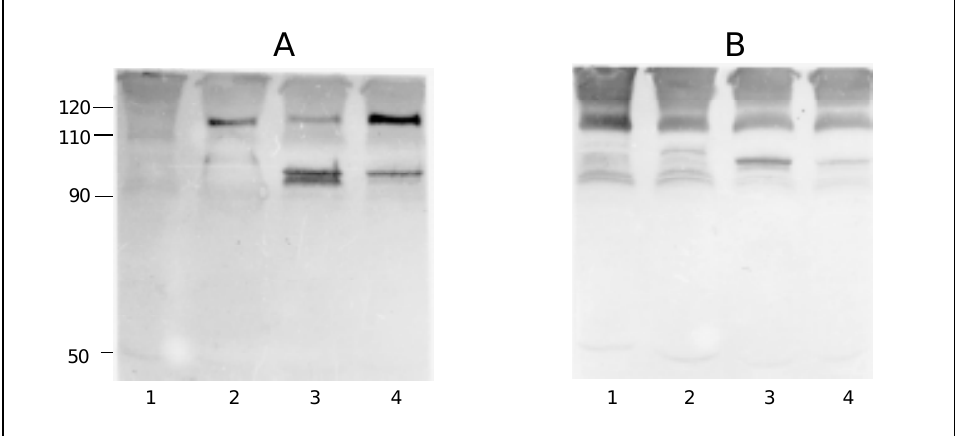
Figure 4 - Western blots of HK and HK-like species in Williams‘ and normal human plasmas. SDS/PAGE and Western blots of plasmas were done as